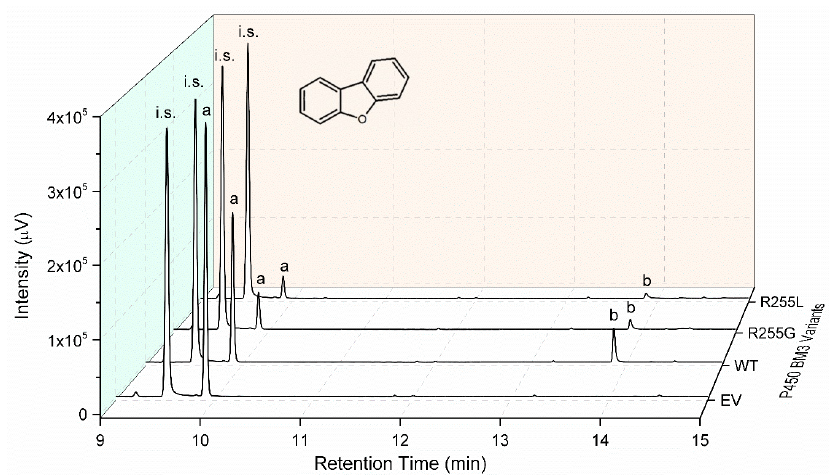
Figure A15. Product analysis via GC-FID after conversion of dibenzofuran with lysate from EV (negative control), P450 BM3 WT, and from variants R255G and R255L. The data was obtained from 1 h